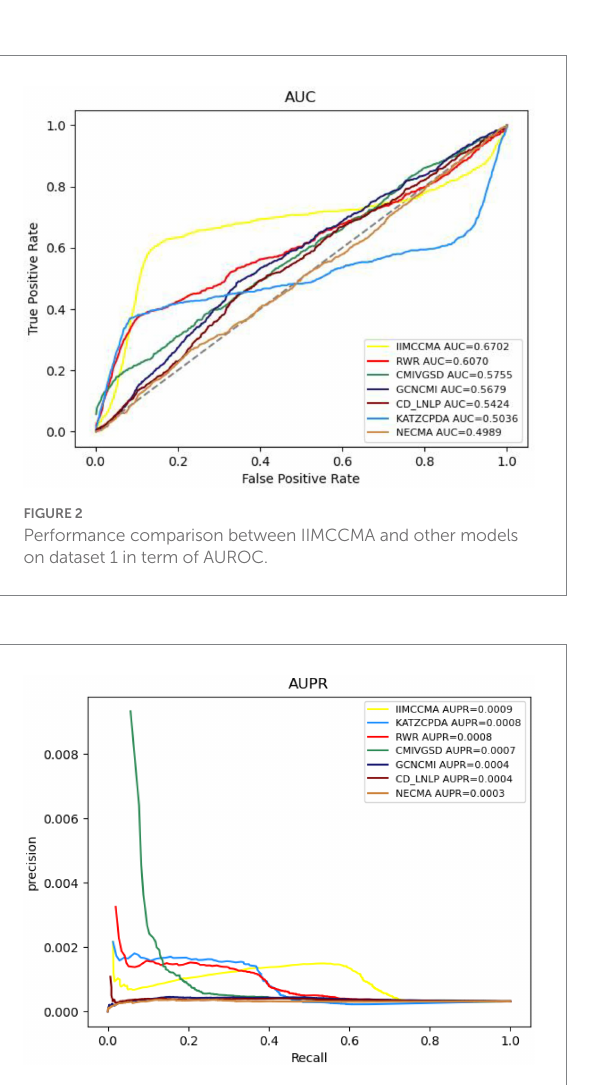
FIGURE 3 Performance comparison between IIMCCMA and other models on dataset 1 in term of